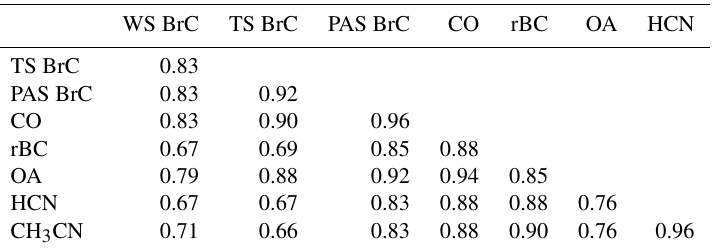
Table 4. Coefficient of determination of linear regression ( R 2 ) for periods of sampling in smoke plumes. For the filter data (WS BrC and TS BrC at 365nm), higher-time-resolution data are averaged to the filter times, and for all others, the comparisons are for 10s merged data. PAS BrC is the inferred absorption coefficient of BrC at 405nm. WS BrC TS BrC PAS BrC CO rBC OA HCN TS BrC 0.83 PAS BrC 0.83